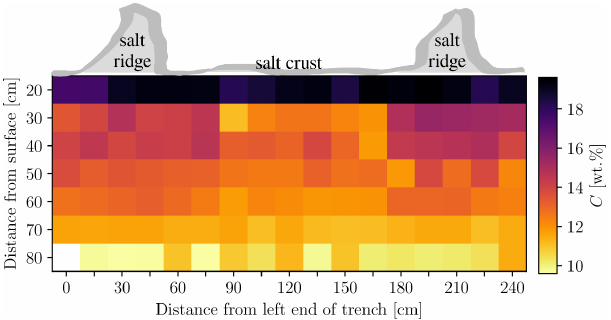
Figure 7. Salinity profile compiled from samples taken at site Owens Lake T27-S P1 in January 2018. The colour code indicates the salt concentration C in